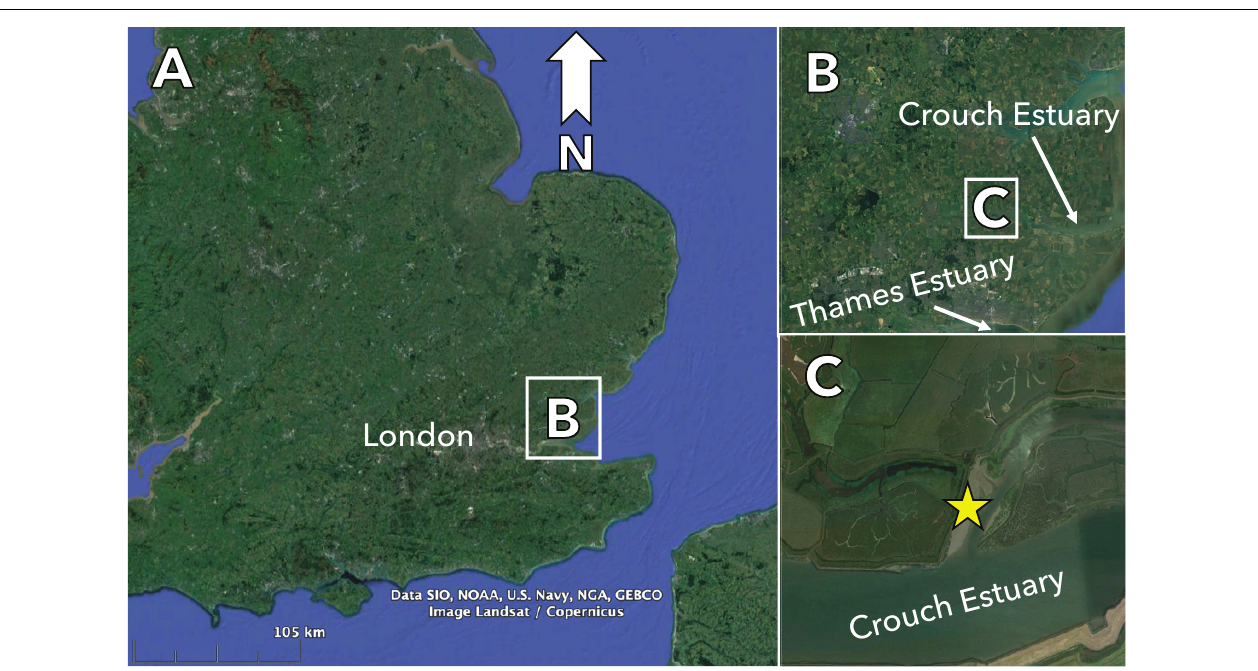
FIGURE 1 | Location of the study site (yellow star) in the Crouch Estuary in the north eastern region of the Thames Estuary in south east England, United Kingdom (Images from Google Earth©).